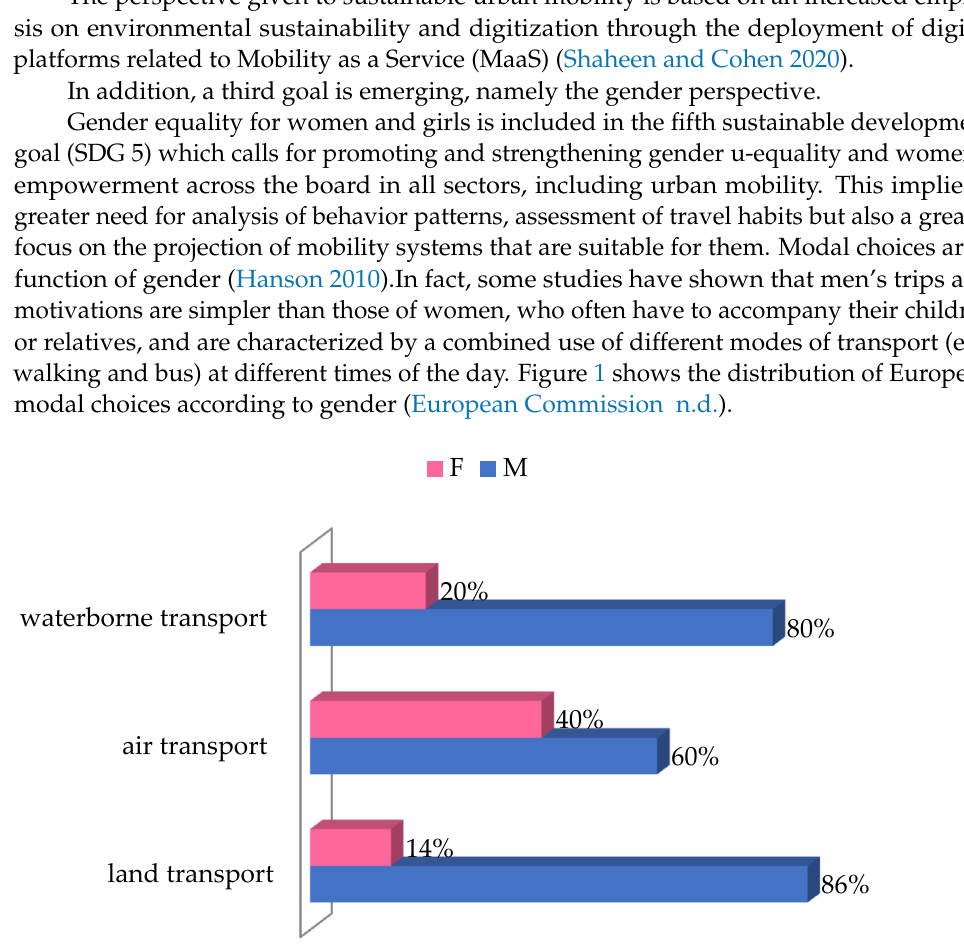
Figure 1. Gender gap trend in Europe (data source: European Commission (n.d.) https://ec.europa.eu/transport/themes/social/women-transport-eu-platform-change_en, accessed on 10 August 2021).